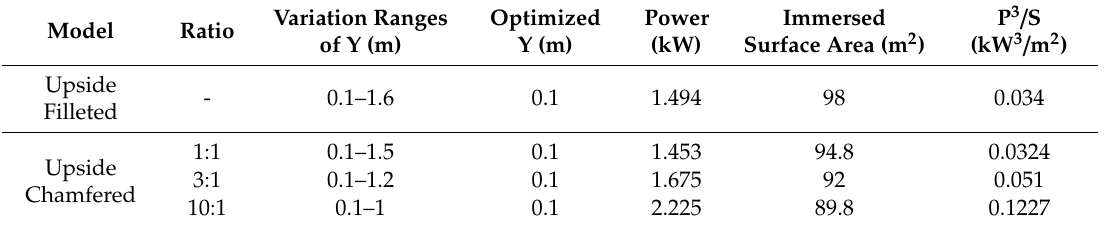
Table 5. The optimized results for the bottom filleted shape.